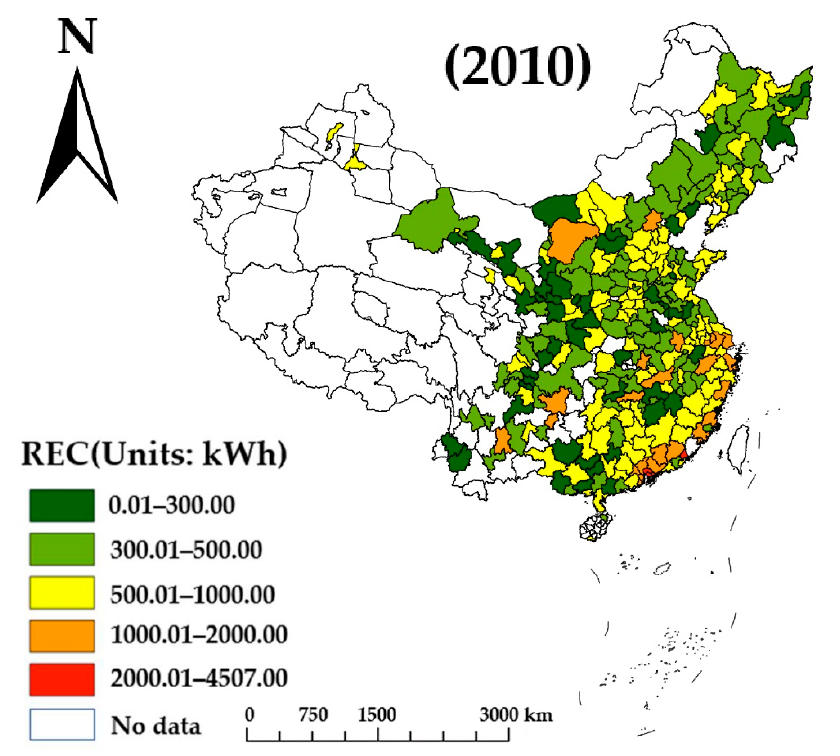
Figure 3. Spatial pattern evolution of China’s REC in 2010.